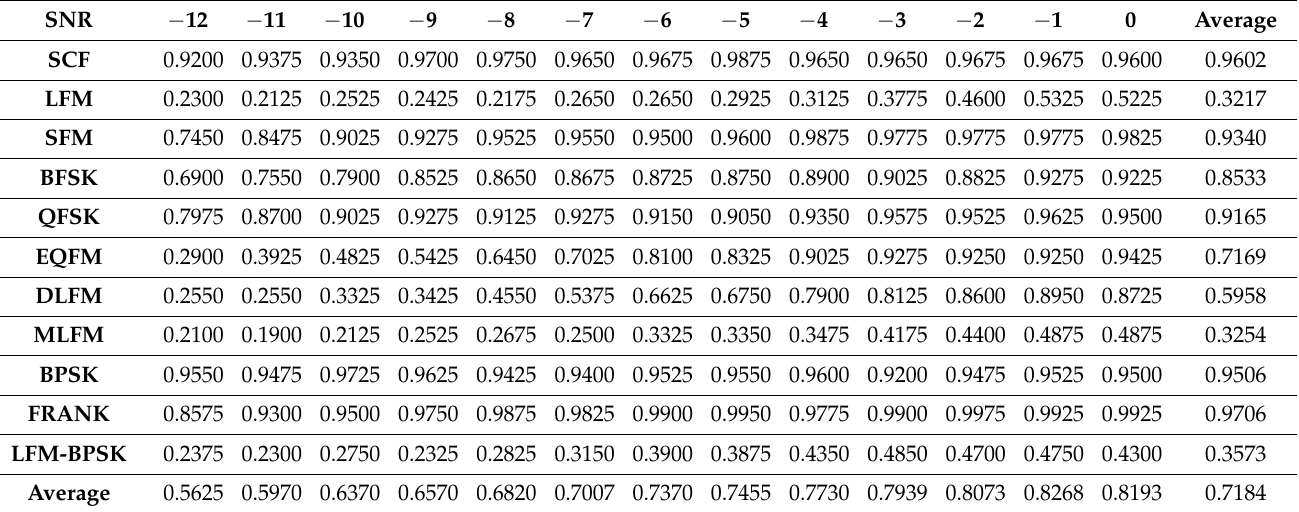
Table A1. The fully supervised classification results with the datasets in Situation Dataset 1.